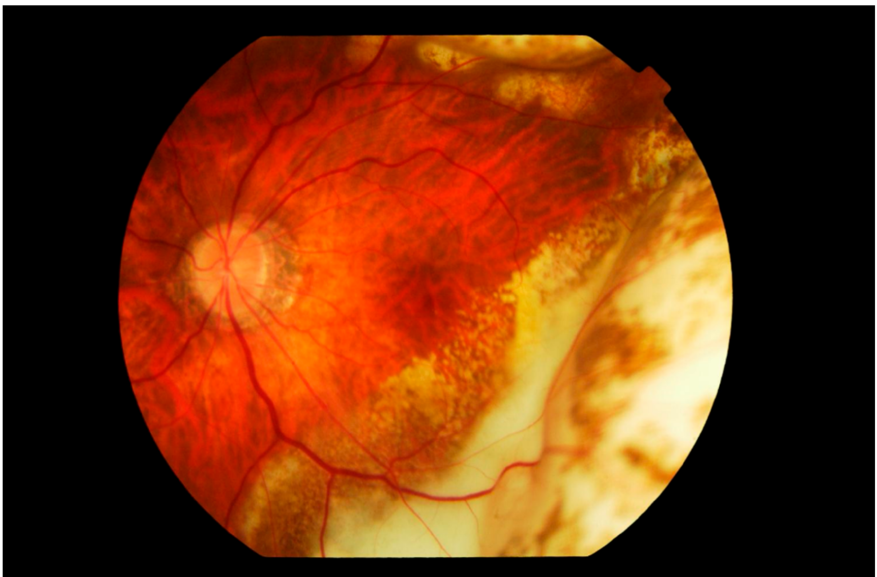
Figure 3. Fundus photograph of the left eye showing subretinal infiltration by lymphoma cells forming multiple large yellowish cream nodular masses distributed circumferentially with patchy pigmentation, giving a characteristic “leopard spot” appearance. The inferior temporal fundus shows the recent development of a wide span of subretinal infiltrates, contiguous with the longer standing peripheral mass. The edge of the lesion advancing towards the fovea consists of multiple small cream-colored spots. The vitreous is clear.